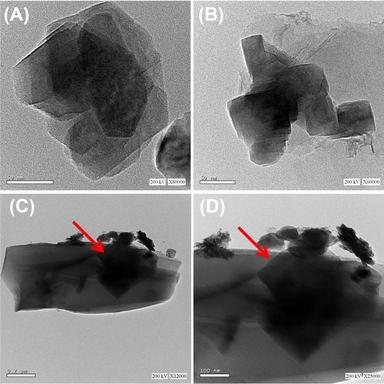
HRTEM images of kaolinite (A), synthetic zeolite-A (B), and the synthetic CF/ZA composite (C and D).